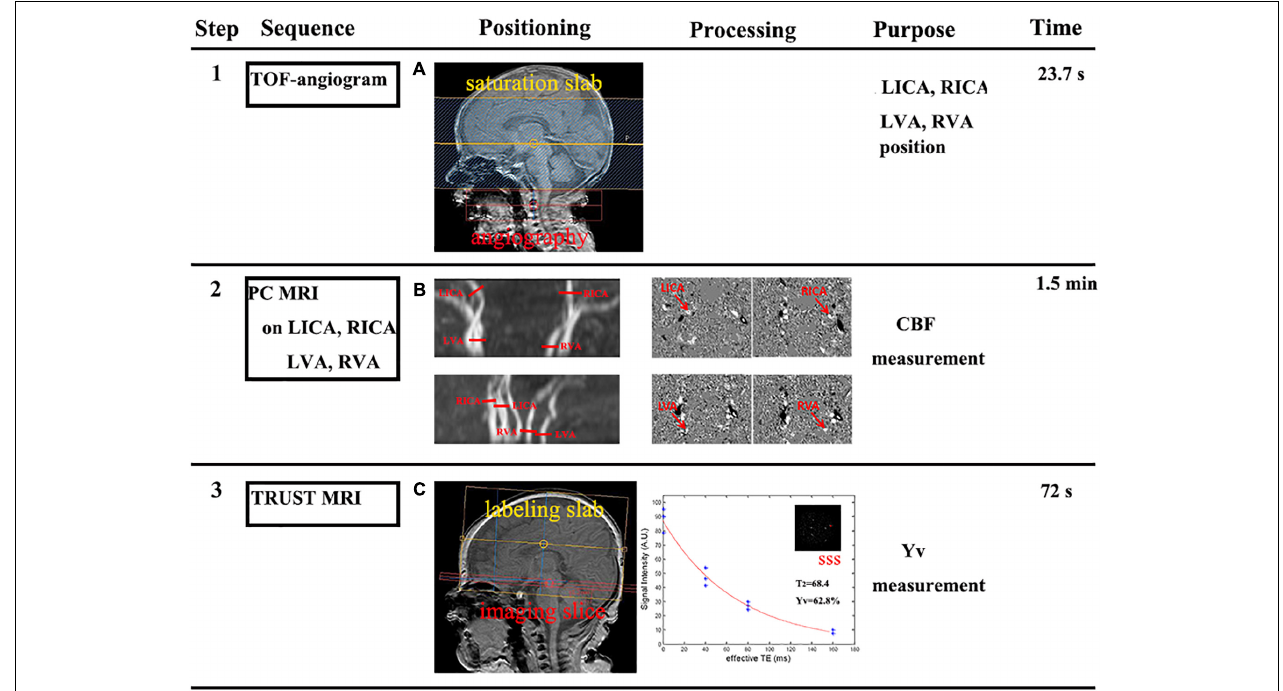
FIGURE 1 | Framework showing how cerebral metabolic rate of oxygen (CMRO 2 ) was measured (steps 1–3). (A) Step 1: a time-of-flight (TOF) MR angiogram (MRA) was performed to position the major feeding arteries of the brain, specifically the left and right internal carotid arteries (LICA and RICA) and the left and right vertebral arteries (LVA and RVA). (B) Step 2: slice positions of the PC MRI scans were overlayed on an angiogram image. Each red bar indicates the imaging slice of one PC MRI scan. Then, the manual delineation of the LICA, RICA, LVA, and RVA, was conducted to determine flux in these vessels. The sum of fluxes by brain weight yielded the cerebral blood flow (CBF). (C) Step 3: the imaging slice was positioned parallel to the intercommissural line with a 10 mm distance. TRUST MRI used a spin-labeling module to isolate pure venous blood signals in the superior sagittal sinus (SSS). Blood signals from the SSS were fitted to a monoexponential function of effective TE to yield blood T 2 ; in turn, this can then be converted to Yv via a calibration